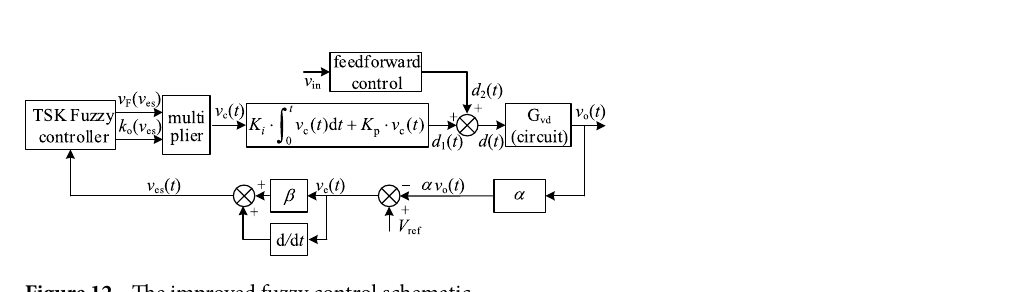
Figure 12. The improved fuzzy control